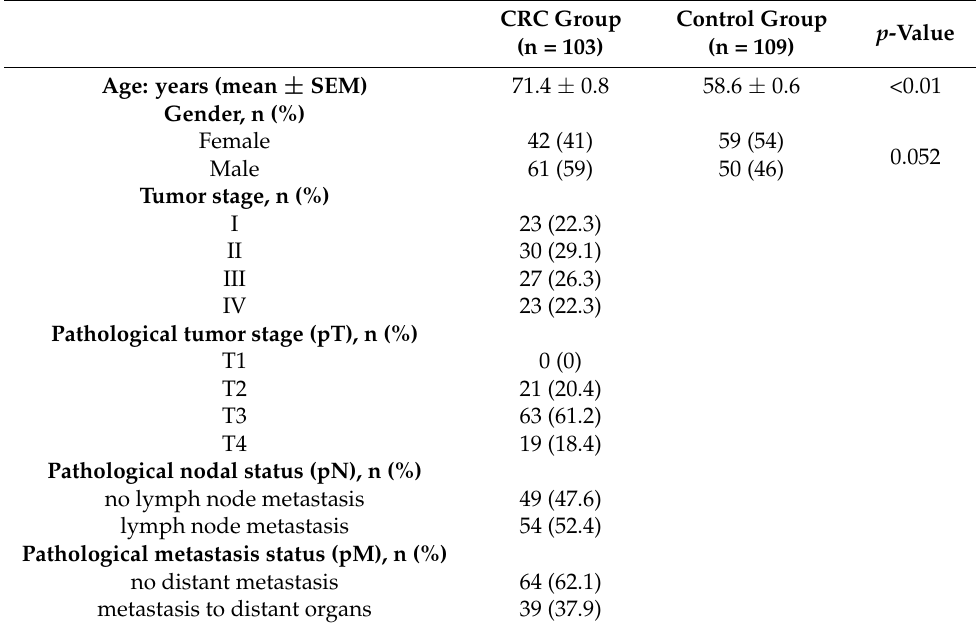
Table 1. Clinical characteristics of patients and participants in the control group. Numbers in brackets indicate the percentage of patients relative to the total group.